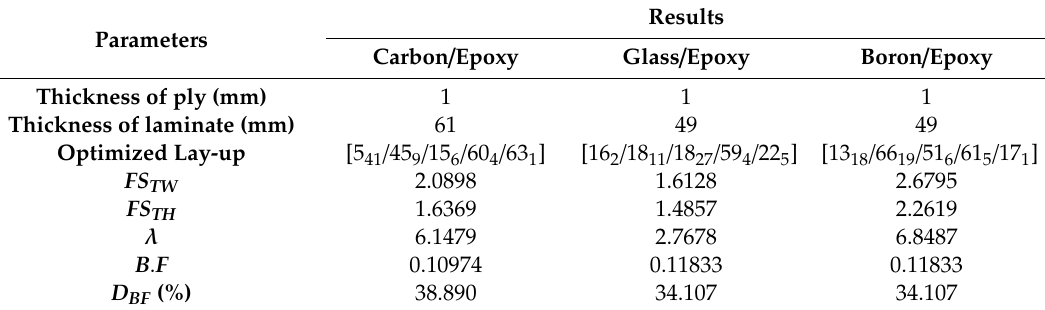
Table 9. Optimal lay-ups for [ β 1S / β 2T / β 3U / β 4V / β 5W